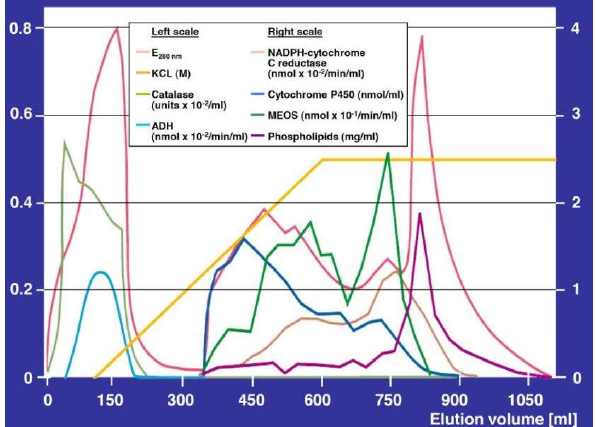
Figure 2. Purification of the microsomal ethanol-oxidizing system (MEOS) and its separation from catalase and alcohol dehydrogenase (ADH) activities. Separation was achieved by DEAE (Diethyl-Amino-Ethyl) cellulose ion exchange column chromatography after solubilization of liver microsomes obtained from rats fed an ethanol containing liquid diet for three weeks. In the void volume eluted up to around 220 mL, the highest peak represents the protein curve assessed as E 280 nm , and the peak below that is the catalase peak, whereas ADH presents as the lowest peak. Starting with an elution volume of around 330 mL, microsomal components begin to appear. The first peak represents cytochrome P450, the second peak represents E 280 nm , followed by a third peak with two shoulders and by a fourth peak representing MEOS. At around 770 mL, the reductase peak emerges, followed by the phospholipid peak at around 790 mL elution volume. Overall, this experimental approach was challenging, putting active MEOS on the top of the column and expecting active MEOS in the effluents. There was a high risk of inactivation of MEOS, not only during the solubilization procedure using ultrasonication and deoxycholate that disintegrated MEOS out of the intact microsomal membranes, but also during the chromatography procedure itself that could lead to the inactive cytochrome P420 from the active P450. The original figure was published in a previous report [30] and is reproduced with permission of the Publisher Elsevier (Amsterdam, The